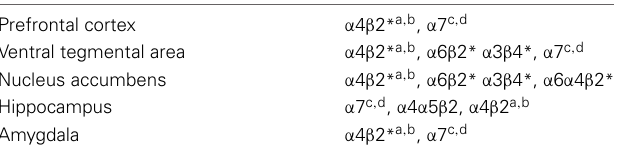
Table 1 | Localization of brain nAChR subtypes (heteromeric 1 and homomeric 2